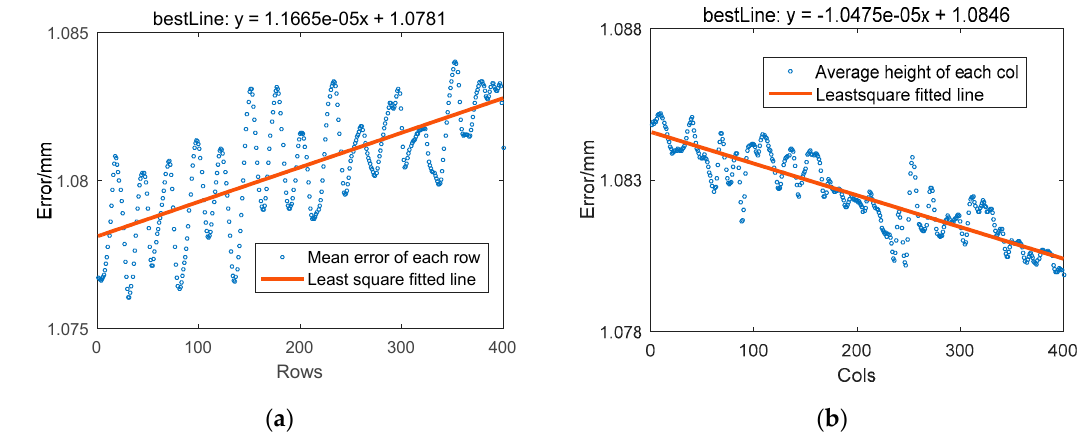
Figure 6. Slant correction based on the least-squares method. ( a ) Correction result of Figure 5a; ( b ) Correction result of Figure 5b.